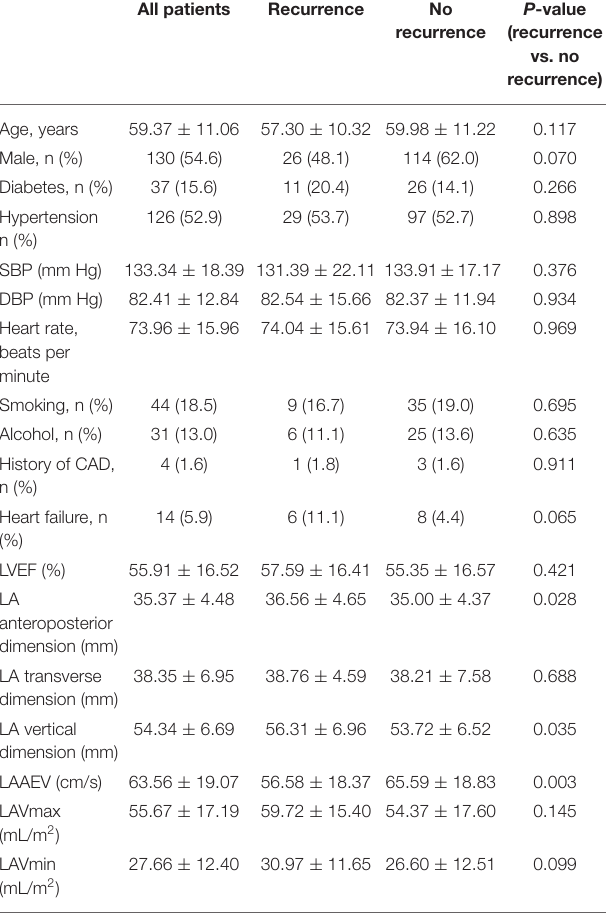
TABLE 3 | Characteristics of recurrence and no-recurrence patients. All